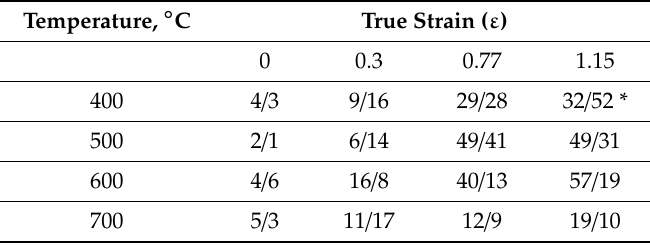
Table 2. Volume fraction of areas with the < 001 >// compression direction (CD) (numerator, %) and < 111 >// CD (denominator, %) texture components in the Fe-0.36wt.%C-1wt.%Cr steel after di ff erent compression strain. Temperature, ◦ C True Strain ( ε ) 0 0.3 0.77 1.15 400 4 / 3 9 / 16 29 / 28 32 / 52 * 500 2 / 1 6 / 14 49 / 41 49 / 31 600 4 / 6 16 / 8 40 / 13 57 / 19 700 5 / 3 11 / 17 12 / 9 19 / 10 * for temperature of 400 ◦ C, maximum strain is equal to